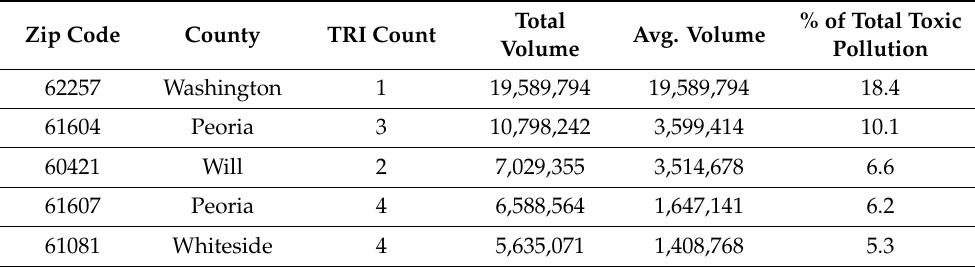
Table 3. Zip Codes with the greatest amount of toxic